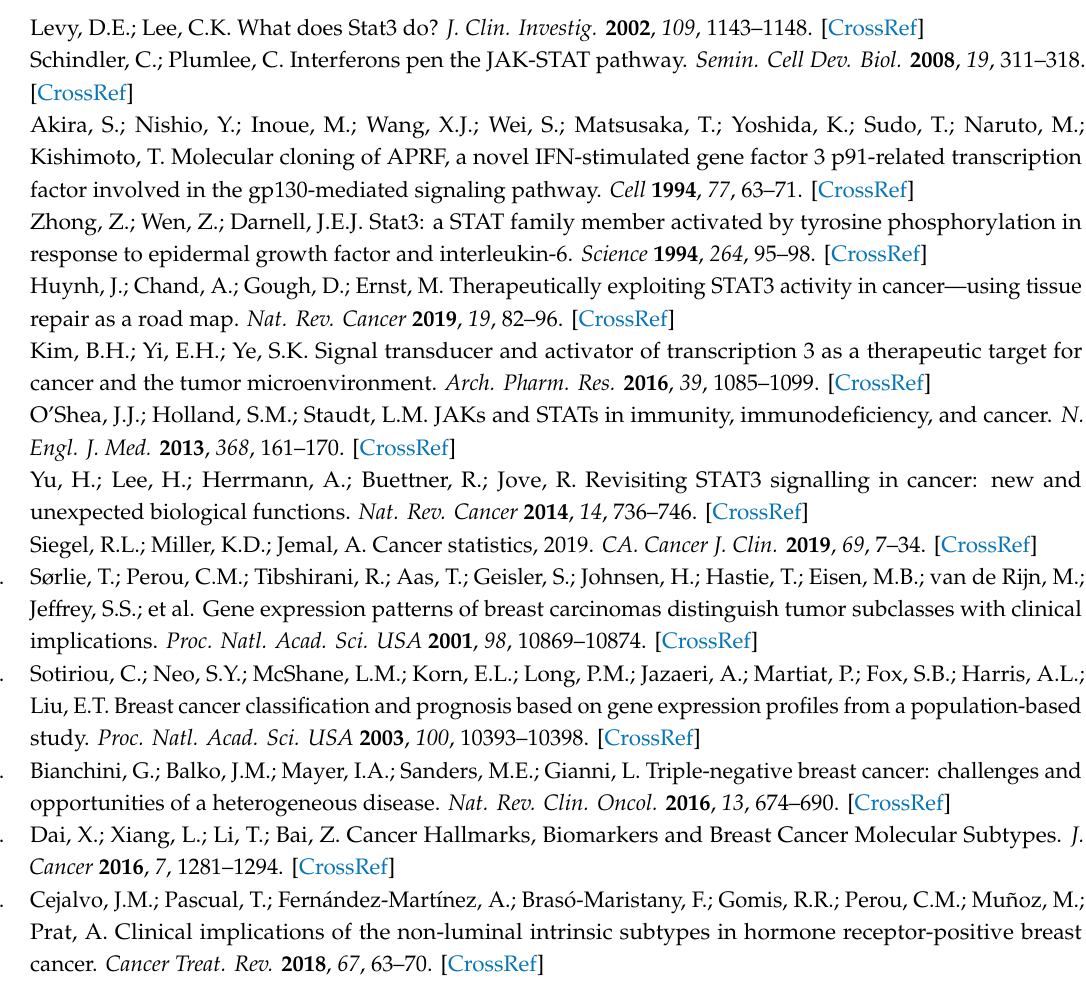
compound of STAT3 inhibitor. Figure S3: Identification of ODZ10117 as a STAT3 inhibitor from the optimization of ODZ17690. Figure S4: 2D-interaction images of Pro704-pTyr705-Leu706 (A), S3I-201 (B), and STA-21 (C) are shown and various interaction types are color-coded. Figure S5: 1H NMR (A) and 13C NMR (B) spectra of the 2-(2,4-dichlorophenoxy)acetonitrile (A1). Figure S6: 1H NMR (A) and 13C NMR (B) spectra of the 2-(2,4-dichlorophenoxy)-N’-hydroxyacetimidamide (A2). Figure S7: 1H NMR (A) and 13C NMR (B) spectra of the ODZ10117. Figure S8: MDA-MB-231 cells were transfected with either HA- or Flag-tagged STAT3 plasmid, incubated for 24 h with either vehicle (0.1% DMSO) alone or ODZ10117 (40 µ M), and then performed immunoblot analysis. Figure S9: ODZ10117 inhibits tyrosine phosphorylation of STAT3 in breast cancer. Figure S10: ODZ10117 does not a ff ect other STAT family members and upstream regulators of STAT3. Figure S11: ODZ10117 does not a ff ect body weight in the orthotopic metastasis